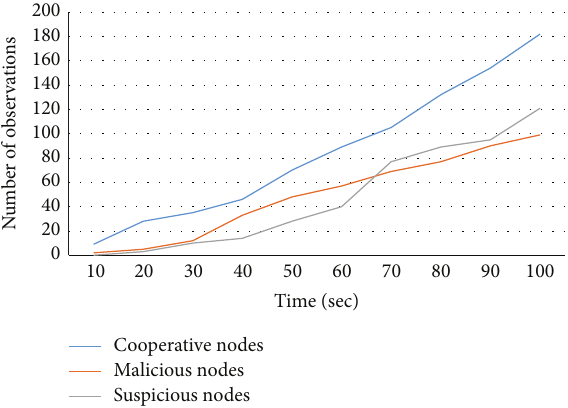
Figure 10: Number of observations made for all nodes.